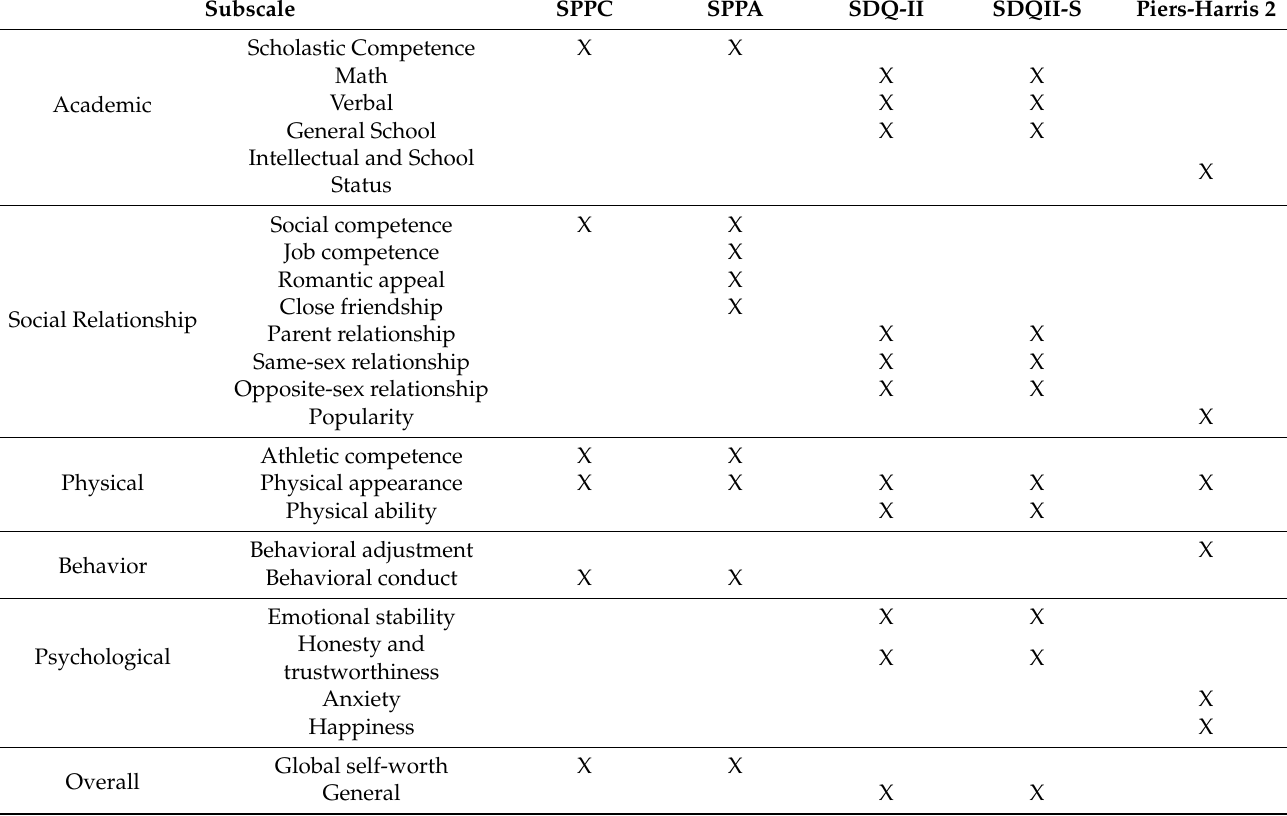
Table 2. Subscales of the self-concept instruments used for